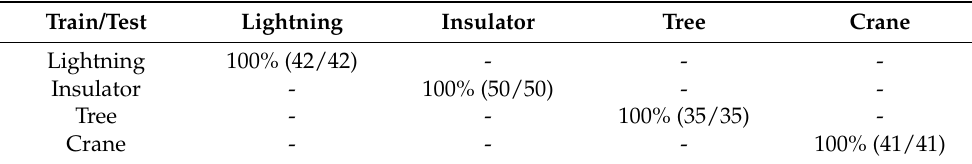
Table 12. Accuracy of the created decision tree w.r.t. curvature predictor selection on test set data for 80% training and 20% testing.